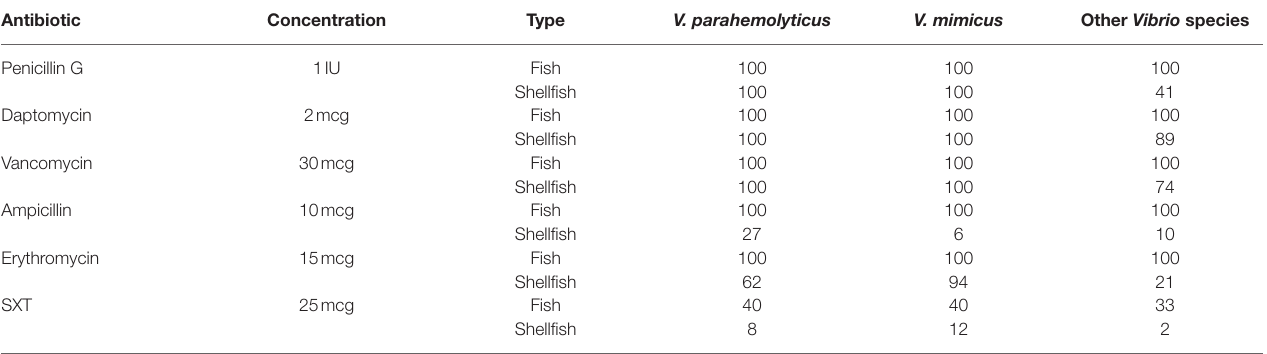
TABLE 2 | Percentage of Vibrio spp., isolates resistant to antibiotics. Antibiotic